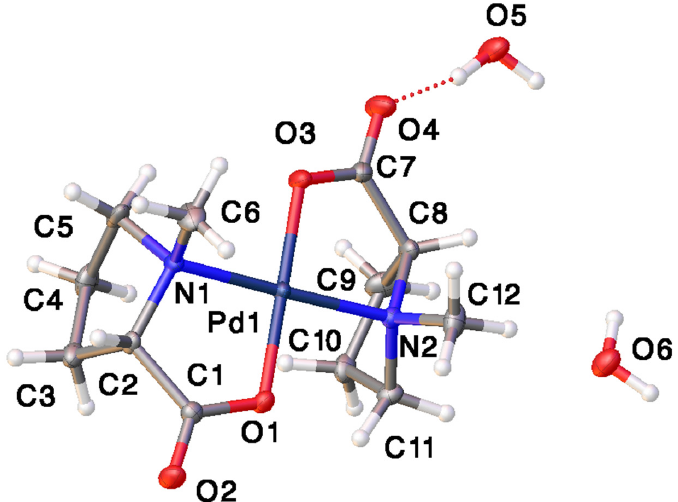
Figure 5. Thermal ellipsoid plot of the molecular structure of crystalline trans -bis-( N